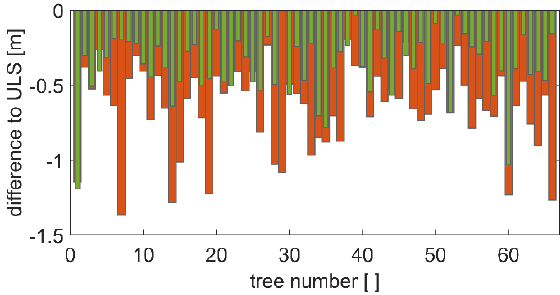
Figure 5. Differences of estimated tree top from ULS to ALS (red) and ULS to ALB